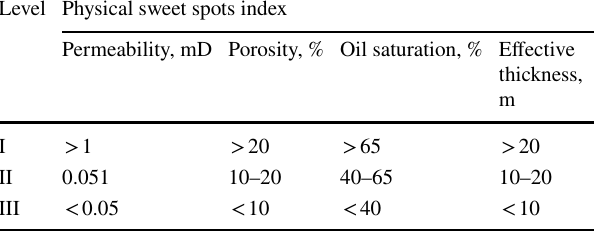
Table 3 Classification summary of single index of physical sweet spots3 Level Physical sweet spots index Permeability, mD Porosity, % Oil saturation, % Effective